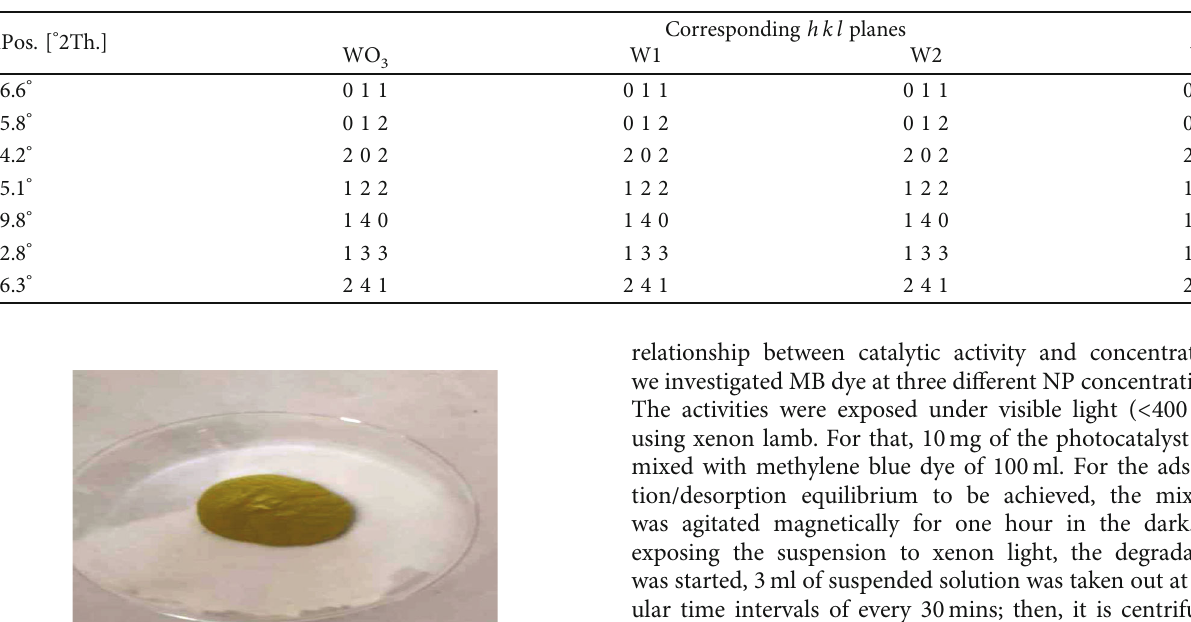
Figure 1: Schematic diagram of the WO Table 1: Crystal phase structure of WO